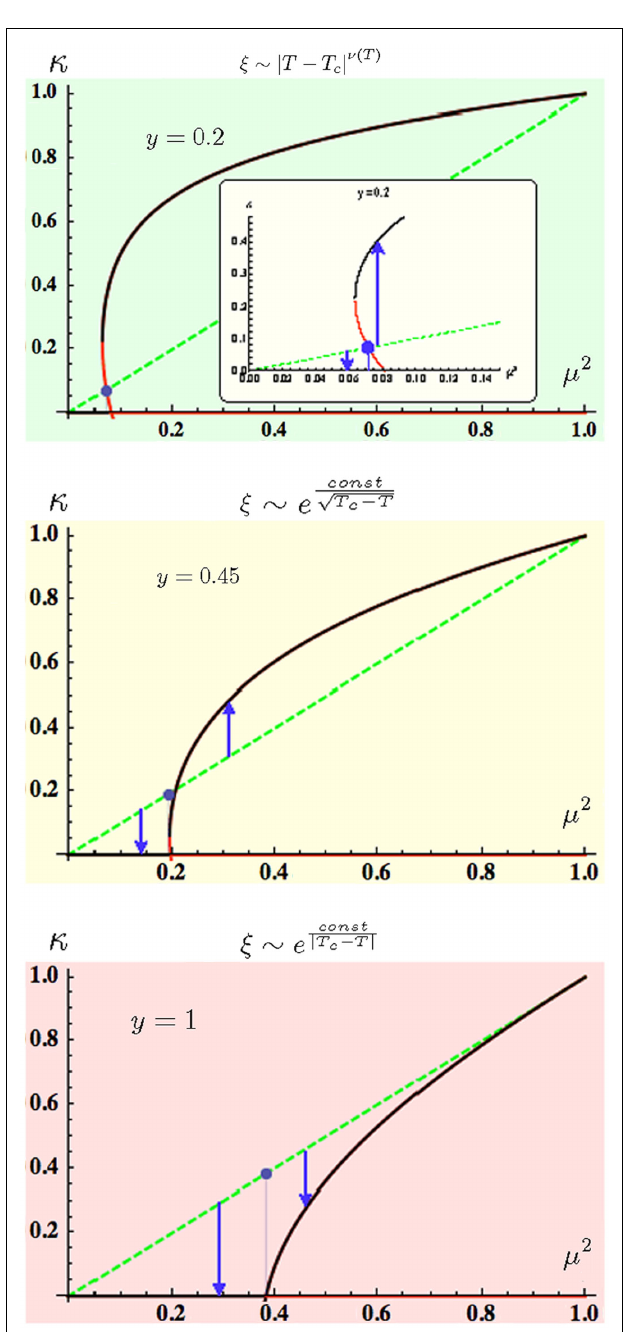
FIGURE 5 | Plot of κ ∗ in Eq. (19) as a function of μ 2 for y as defined in Eq. (12). The generic cases are represented by y = 0.2 (top), y = 0.45 (middle), and the case of HN5 discussed in Section 4 for y = 1 (bottom), for which the branch-point (BP) has “sunset” out of the physical regime. In all cases, the dashed, green-shaded line indicates the initial conditions (IC) for the RG flow in Eqs. (13, 14), κ (0) = μ 2 . For μ fixed, the RG flow must proceed vertically, either up or down, to the nearest stable line of fixed points. For low y (top), the IC crosses the unstable branch below BP (see enlargement in the inset) which then can not be reached by the flow. Once the IC cross above BP (middle), the flow must pass BP, unless BP sunsets (bottom). For each case, the generic divergence is indicated for the correlation length ξ at T → T c , as derived in Section